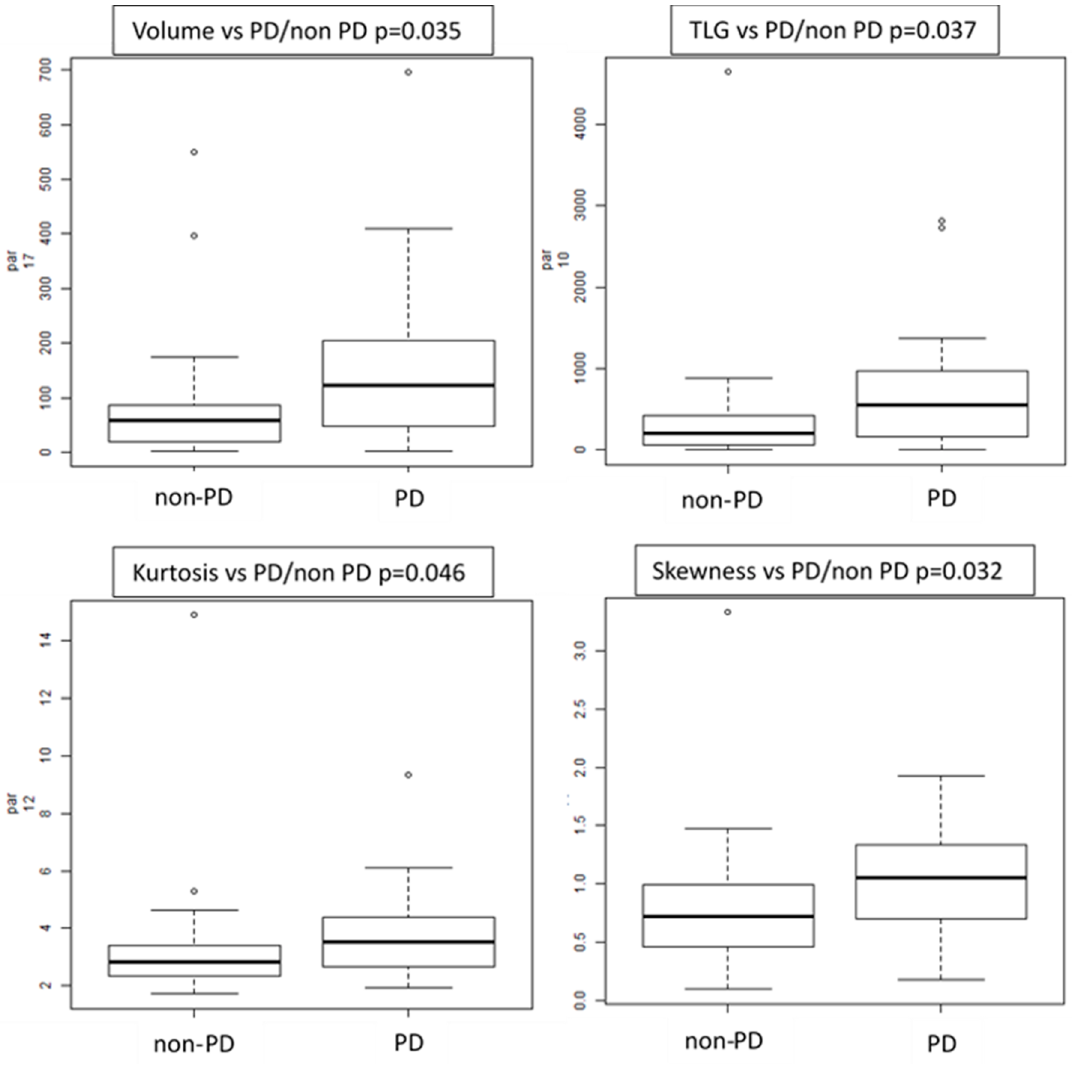
Figure 4. Box plots of radiomics features correlated with progressive (PD) vs. non-progressive disease status